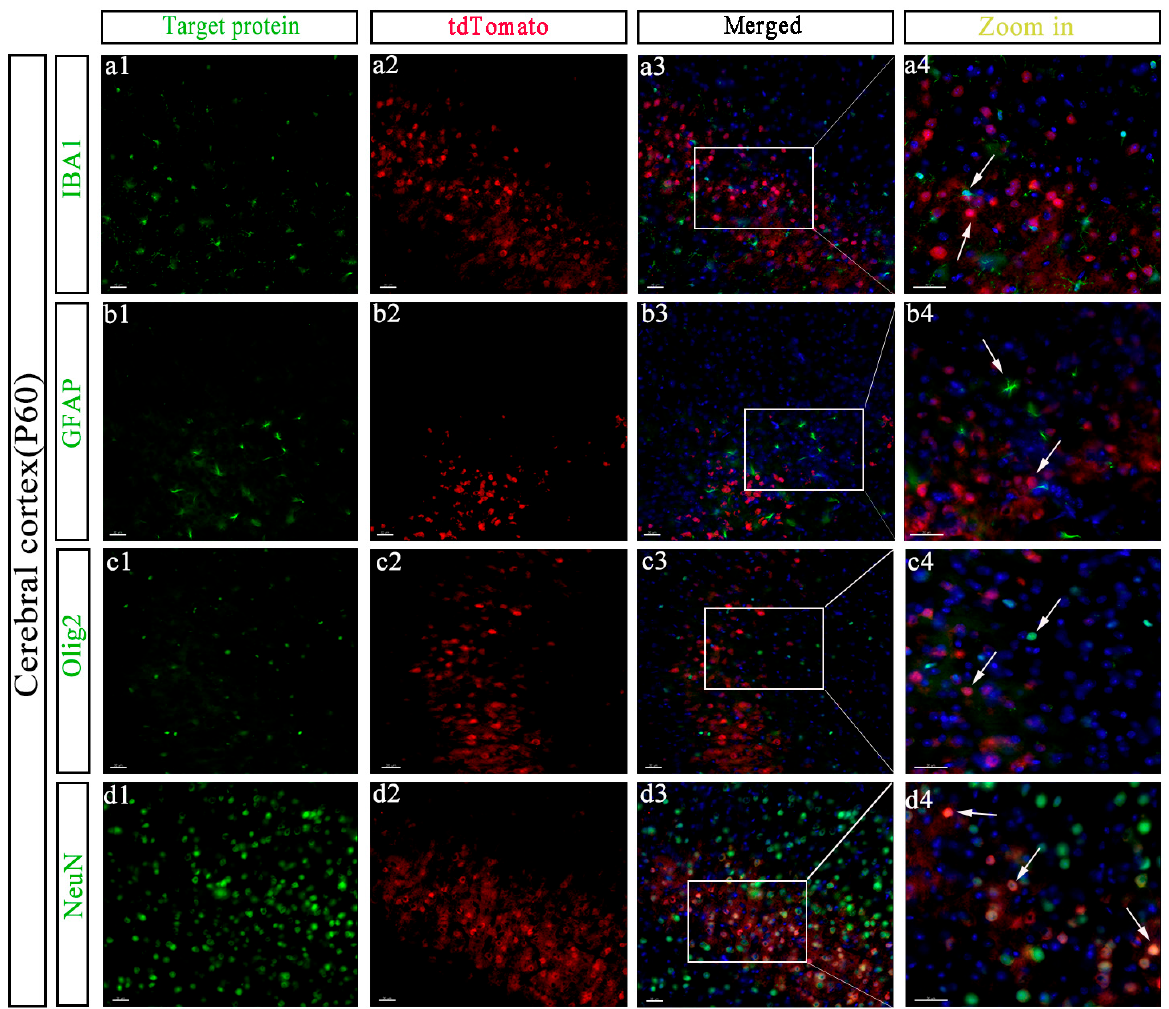
Figure 4. Expression of GPR158 in neurons in the cerebral cortex of Gpr158 Tag mice at P60. ( a1–a4 ) Immunofluorescence staining on cerebral cortex showed GPR158 (red) was not expressed in microglia. Microglia (green, a1 ) were stained with anti-IBA1 antibody. Local zoomed-in diagram showing the localization of tdTomato + cells in relation to IBA1 + cells in the cerebral cortex of GPR158 Tag mice at P60. ( b1–b4 ) GPR158 + cells were not detected in activated astrocytes (green) of the cerebral cortex of GPR158 Tag mice at P60. Activated astrocytes (green, b1 ) were stained with anti-GFAP antibody. Local zoomed-in diagram showing the localization of tdTomato + cells in relation to GFAP + cells in the cerebral cortex of GPR158 Tag mice at P60. ( c1–c4 ) GPR158 was not expressed in oligodendrocytes (green, c1 ). Oligodendrocytes (green) were stained with anti-olig2 antibody. Local zoomed-in diagram showing the localization of tdTomato + cells in relation to olig2 + cells in the cerebral cortex of GPR158 Tag mice at P60. ( D ) GPR158 (red, d1–d4 ) were expressed in neurons (green, d1 ) in the cerebral cortex of GPR158 Tag mice at P60. Neurons (green) were stained with anti-NeuN antibody. GPR158 (red) were stained with anti-mCherry antibody. Nuclei (blue) were stained with DAPI. Scale bars, 30 μ m.